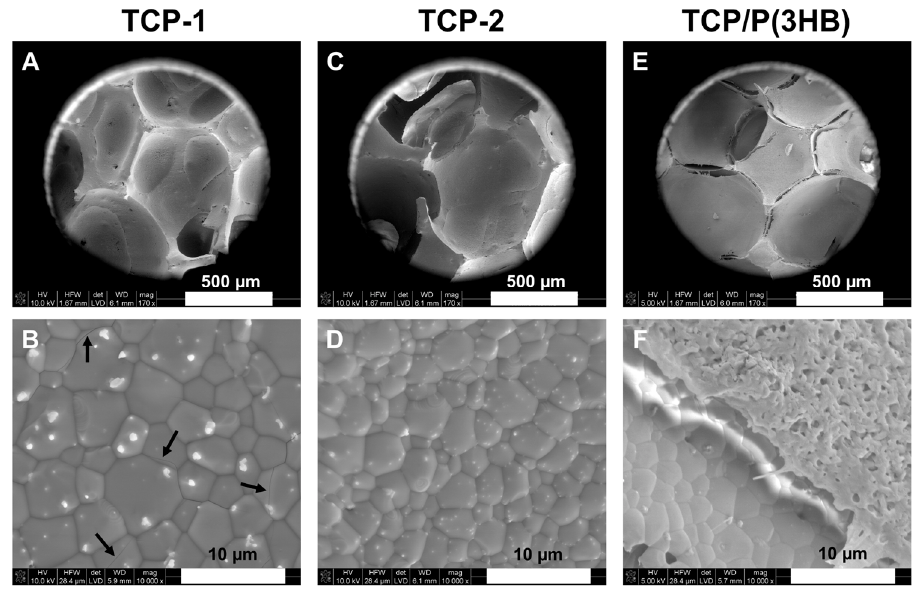
Figure 3. SEM microphotographs of scaffolds: TCP-1 ( A , B ), TCP-2 ( C , D ) and TCP/P(3HB) ( E , F ). Arrows indicate local intergranular cracks.